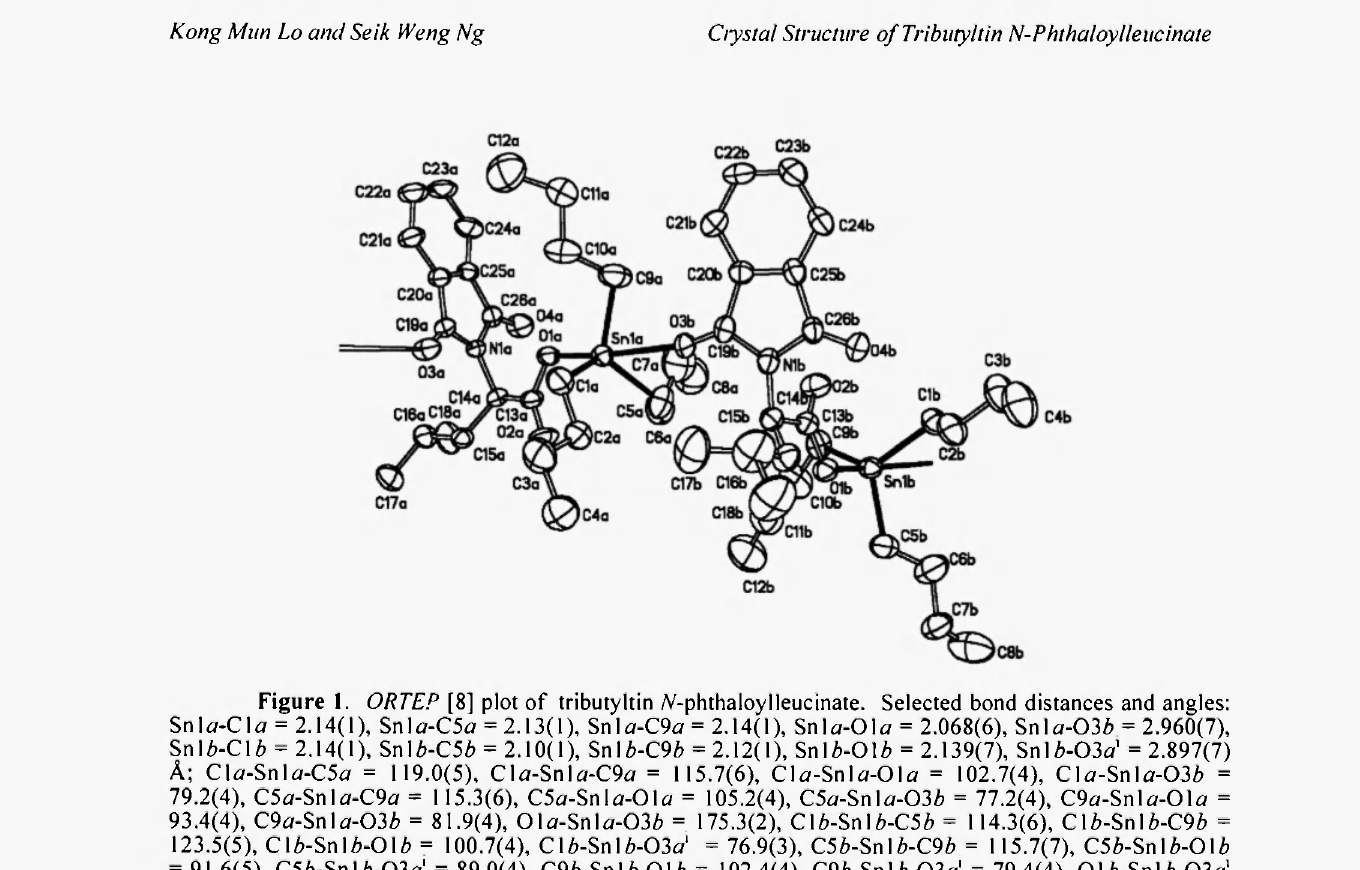
= 177.5(3)°. Translational code: /= I +x,y, 1